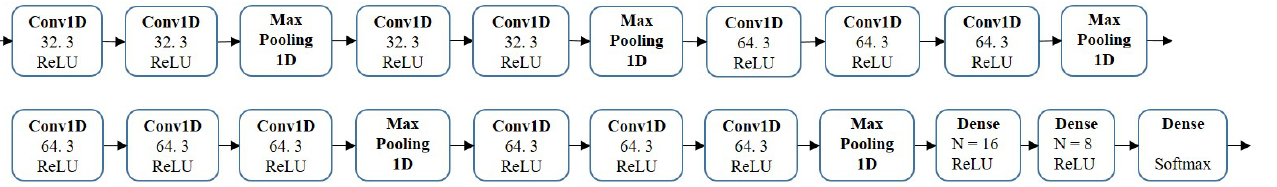
Figure 6. The network architecture of